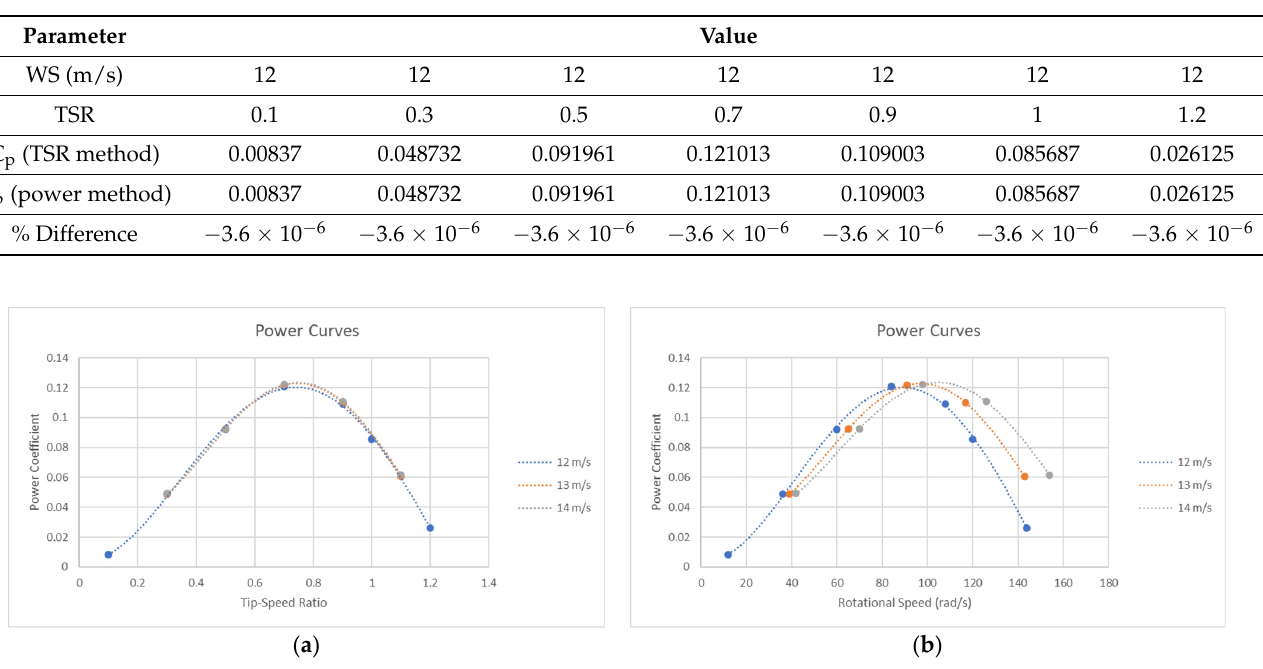
Figure 8. Power curves of unaltered Darrieus VAWT plotted against: ( a ) Tip-speed ratio (TSR); ( b ) Rotational speed.